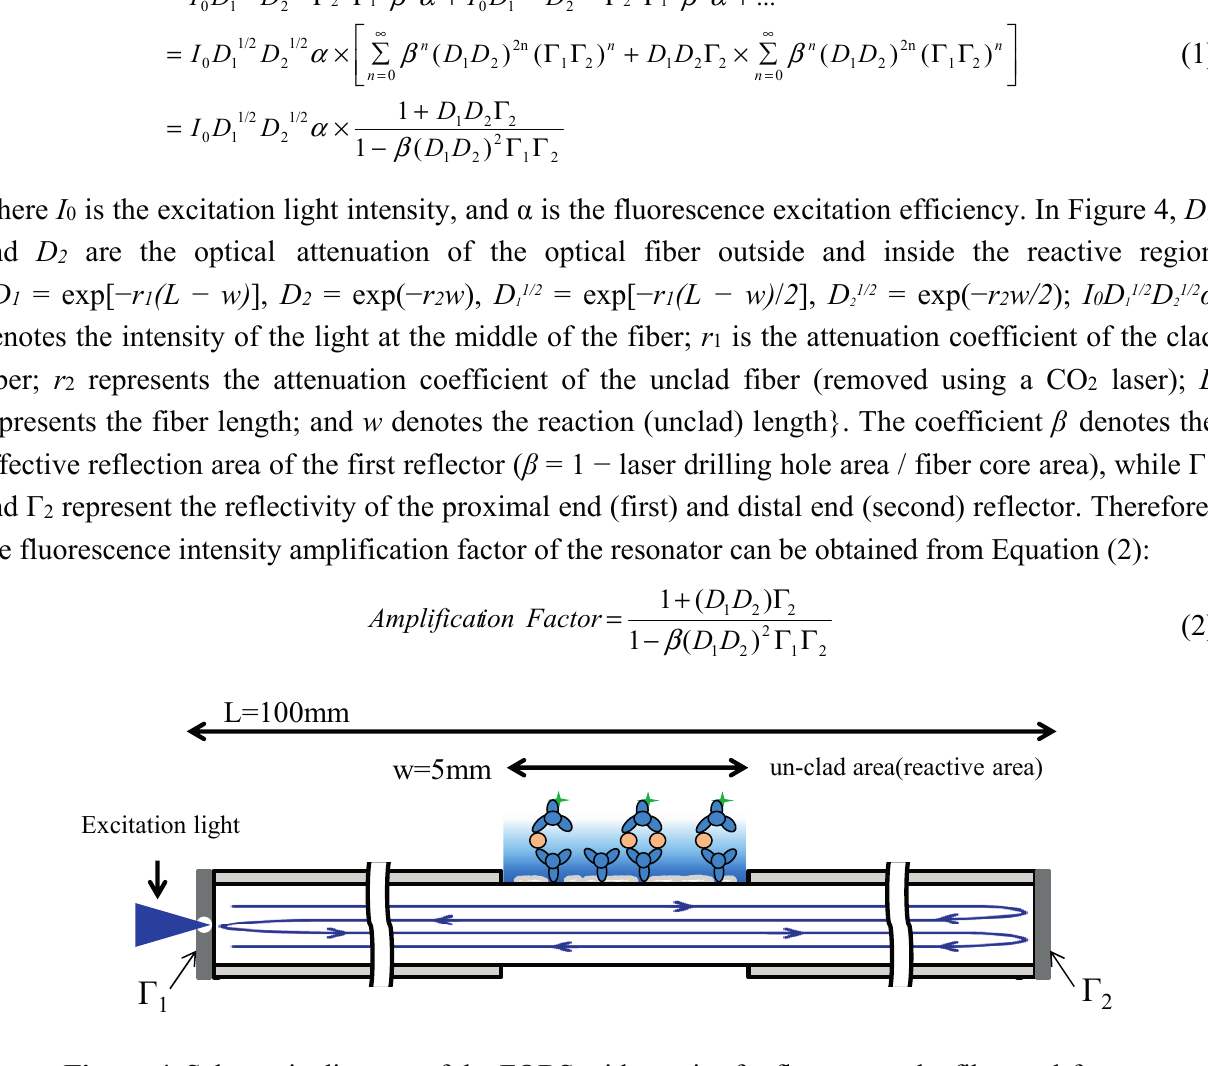
Figure 4. Schematic diagram of the FOBS with a pair of reflectors on the fiber